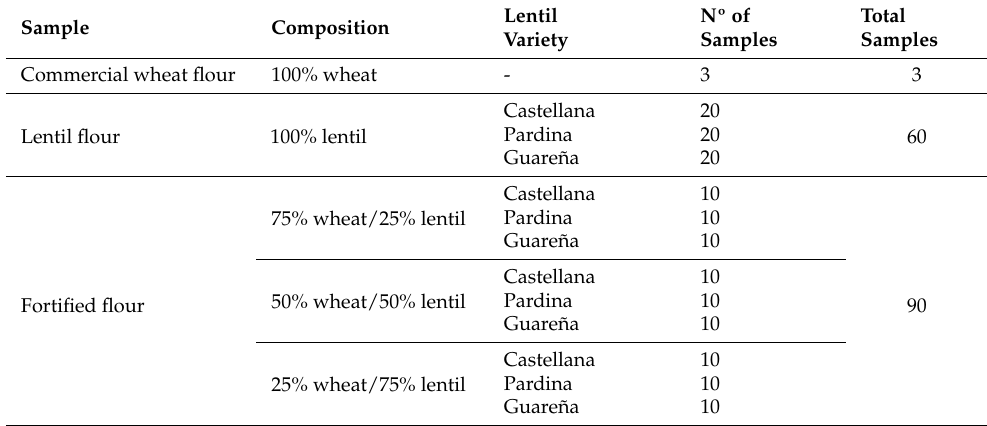
Table 1. Composition and number of flour samples